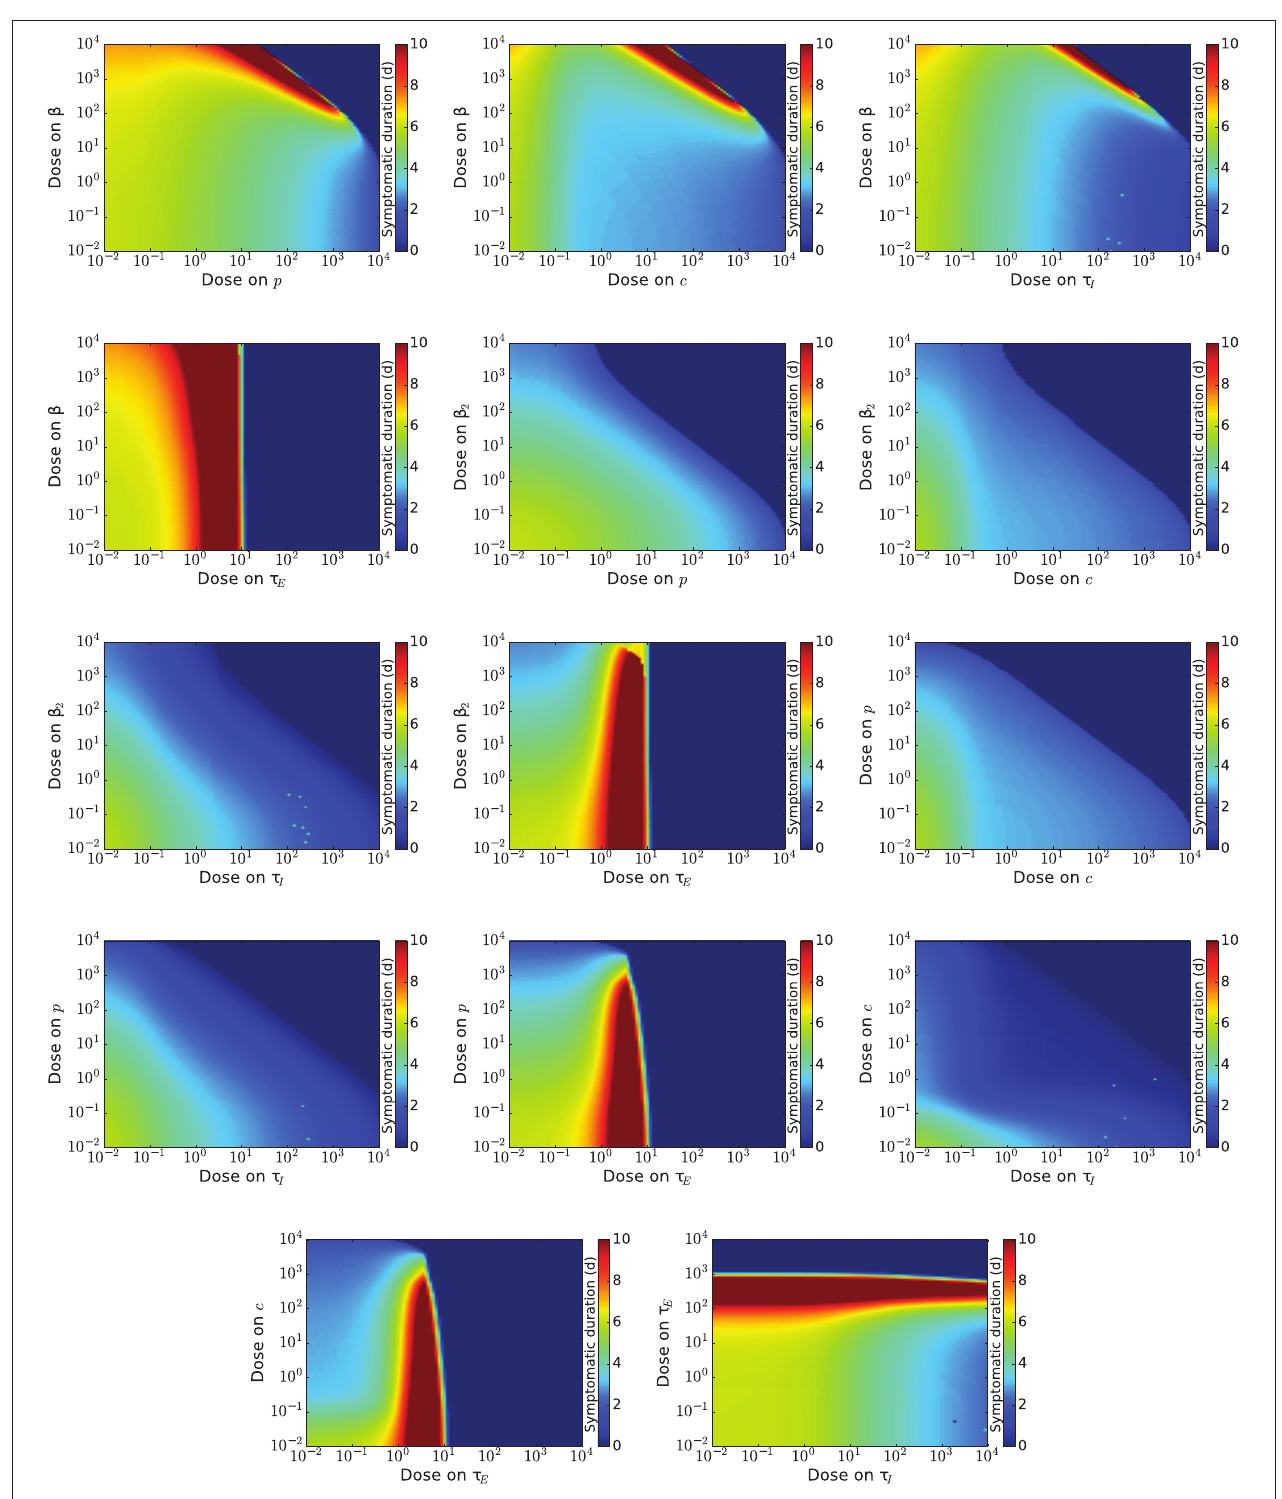
FIGURE 3 | Infection duration for a range of doses of various combinations of influenza antivirals. Regions where the infection has been cured, (duration=0) are indicated by dark blue, while regions where the infection is longer than 10 days are indicated by red.